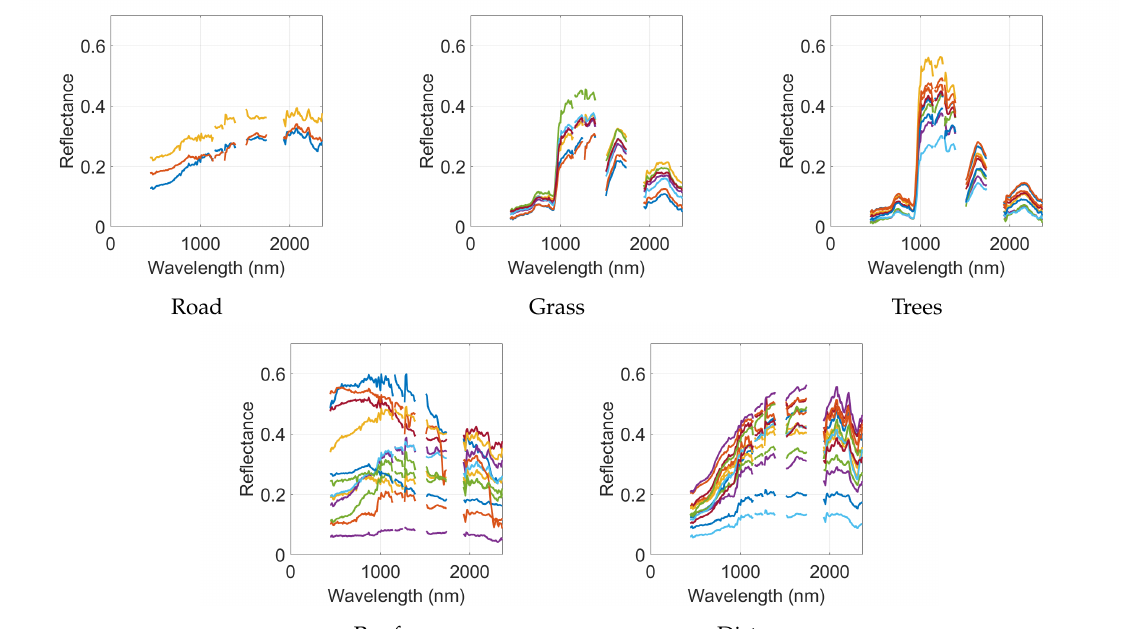
Figure 15. Spectral signatures associated with the Urban information